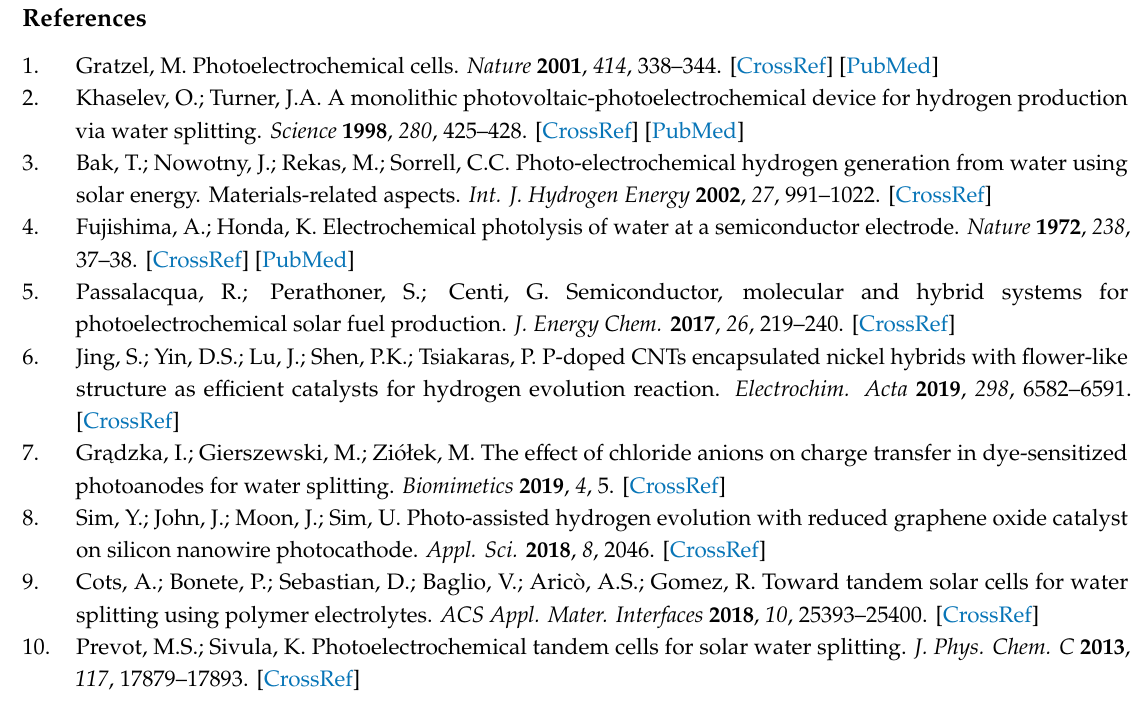
Figure S1: XRD pattern for a hematite / FTO electrode calcined at 650 ◦ C for 1 h, Figure S2: Polarisation curves in an extended window under illumination and in the dark for the co-catalyst-based cells reported in Figure 3, Figure S3: EDX analysis of the outer NiFeOx-coated hematite photoanode surface, Figure S4: Registration of H 2 ionic current at the cathode outlet of a specifically designed 4 cm 2 tandem photoelectrolysis cell using a mass spectrometer, under dark and light conditions, Figure S5: Short-term durability study of a tandem 0.25 cm 2 photoelectrolysis cell fully immersed in water and illuminated by a solar lamp, Figure S6: AM1.5 spectrum utilisation by 2.1 eV bandgap of doped Fe 2 O 3 (blue shading) and by 1.2 eV bandgap CuO underneath (green